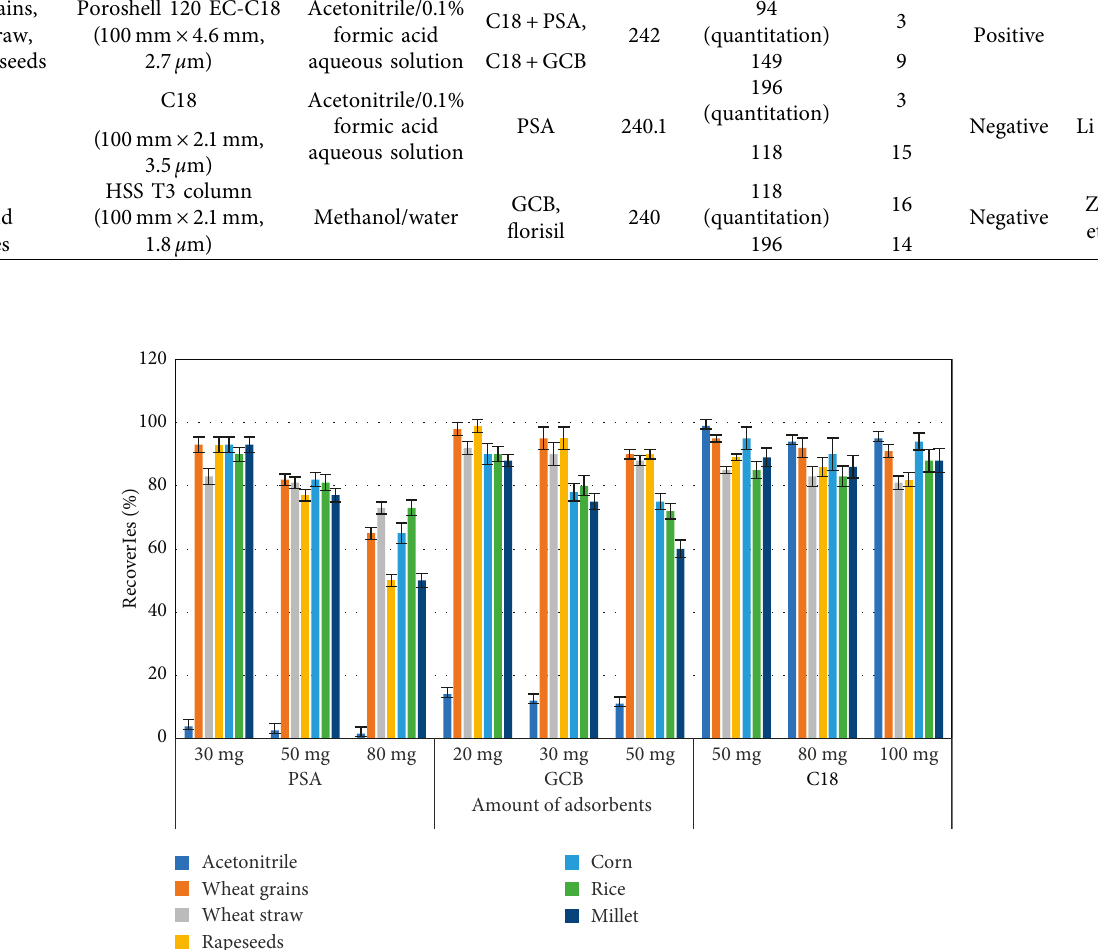
Figure 3: The recoveries of phthalanilic acid clean-up by different adsorbents in acetonitrile, cereals, wheat straw, and rapeseed matrix blank